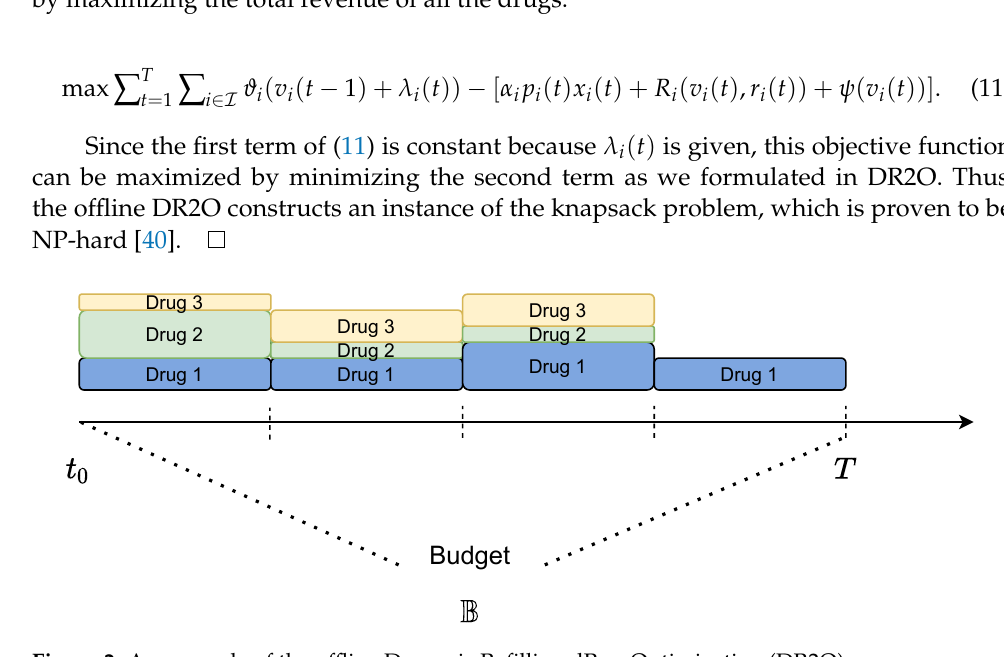
Figure 2. An example of the offline Dynamic Refilling dRug Optimization